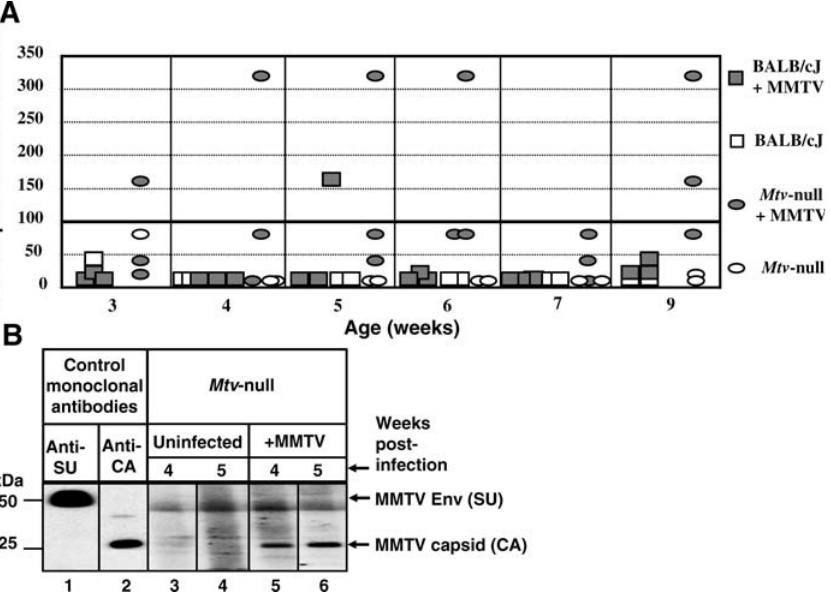
Figure 4. BALB/ Mtv -Null Mice Infected by Milk-Borne MMTV Lack Virus-Specific Neutralizing Antibodies (A) Both BALB/c and Mtv -null animals sporadically have low levels of MMTV-specific antibodies. Sera from milk-borne C3H MMTV-infected (gray symbols) or age-matched non-infected (white symbols) BALB/c (squares) and Mtv -null (circles) mice were analyzed weekly by ELISA to detect virion- specific antibodies. Each symbol represents an individual mouse. The serum antibody titer was calculated as the reciprocal of the highest serum dilution that reacted with MMTV virions. Since one non-infected animal showed a titer of 1:80, values above 1:100 (the heavy line) were considered positive. (B) Sporadic, low-titer antibodies in Mtv -null animals have reactivity to MMTV capsid antigen. Proteins from purified MMTV particles were separated on SDS-containing polyacrylamide gels, subjected to Western blotting, and incubated with a 20-fold dilution of serum from two MMTV-infected Mtv -null mice with the highest antibody titers (1:320) at 4–5 wk of age. MMTV capsid antigen (CA) or surface envelope (SU)-specific monoclonal antibodies were used as positive controls. Sera from two age-matched non-infected BALB/ Mtv -null mice were used as negative